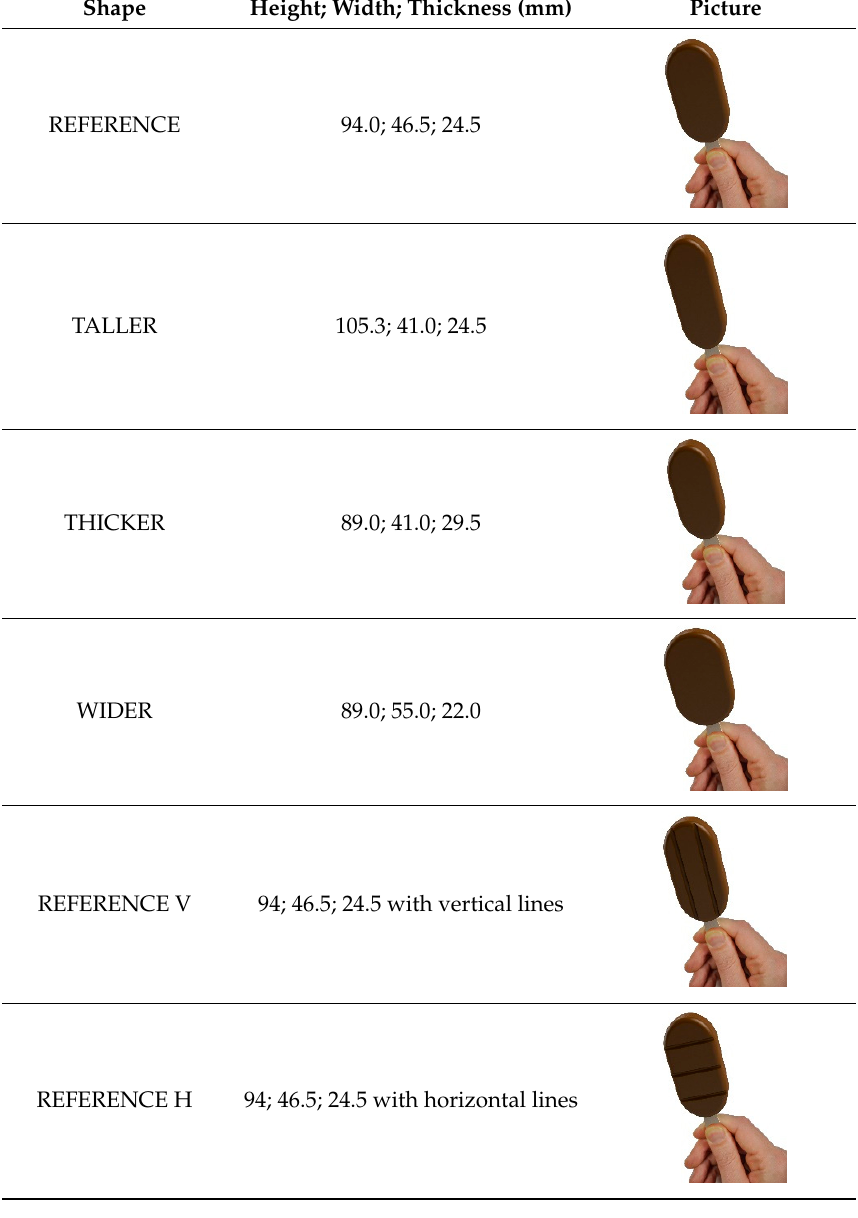
Table 1. Ice cream stick dimensions and pictures for a constant volume of 90 mL.